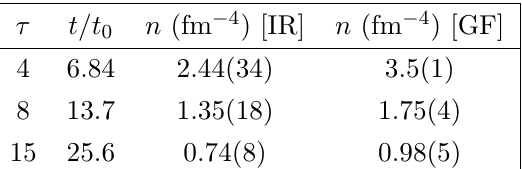
Figure 4 . (Color online) The strong coupling de(cid:12)ned by eq. (2.11), computed from the lattice gauge (cid:12)elds simulated at (cid:12) =4.2 without (brown solid circles) and after applying the Gradient (cid:13)ow with (cid:28) =4 (red), 8 (blue) and 15 (black) and depicted by using logarithmic scales. The lines correspond to the multi-instanton ensemble predictions both at low (solid) and large momenta (dashed), according to eqs. (2.11), (2.12).